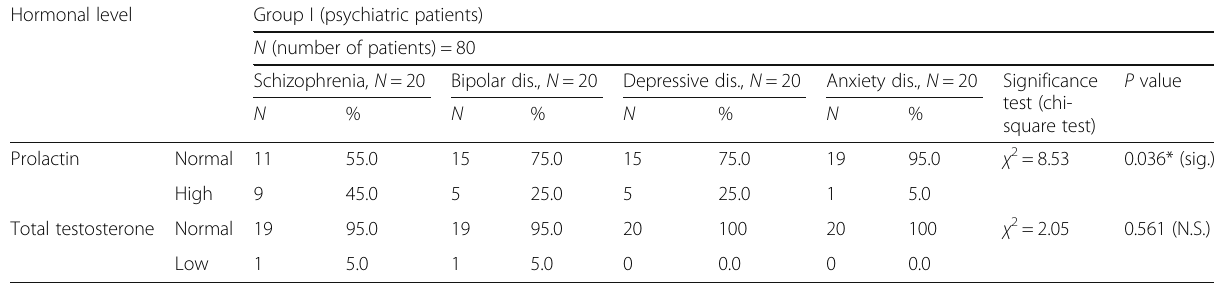
Table 9 Hormonal levels among patients of group I (psychiatric patients) Hormonal level